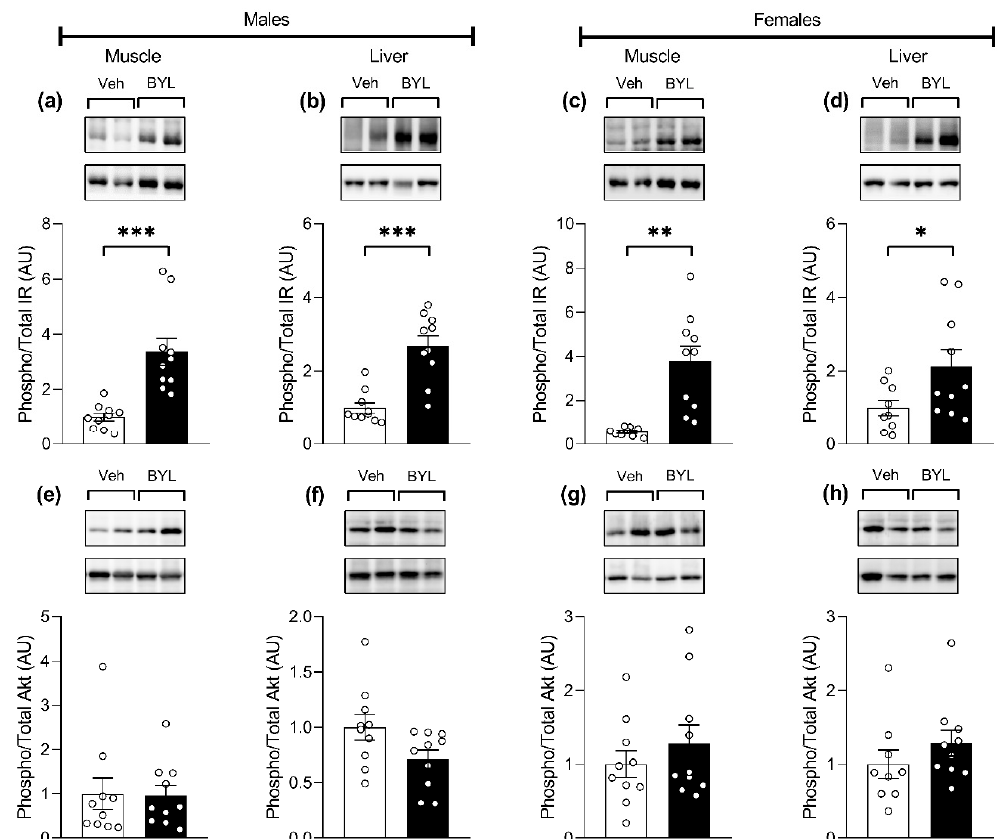
Figure 3. Gastrocnemius muscle and liver insulin receptor (IR) ( a – d ) and Akt ( e – h ) phosphorylation in male and female mice, following 72 h of receiving a control (Veh; vehicle) or BYL719 (BYL)-containing diet. Data are presented as mean ± SE, statistical analysis was by t -test, * p < 0.05, ** p < 0.01, *** p < 0.001 vs. Veh.